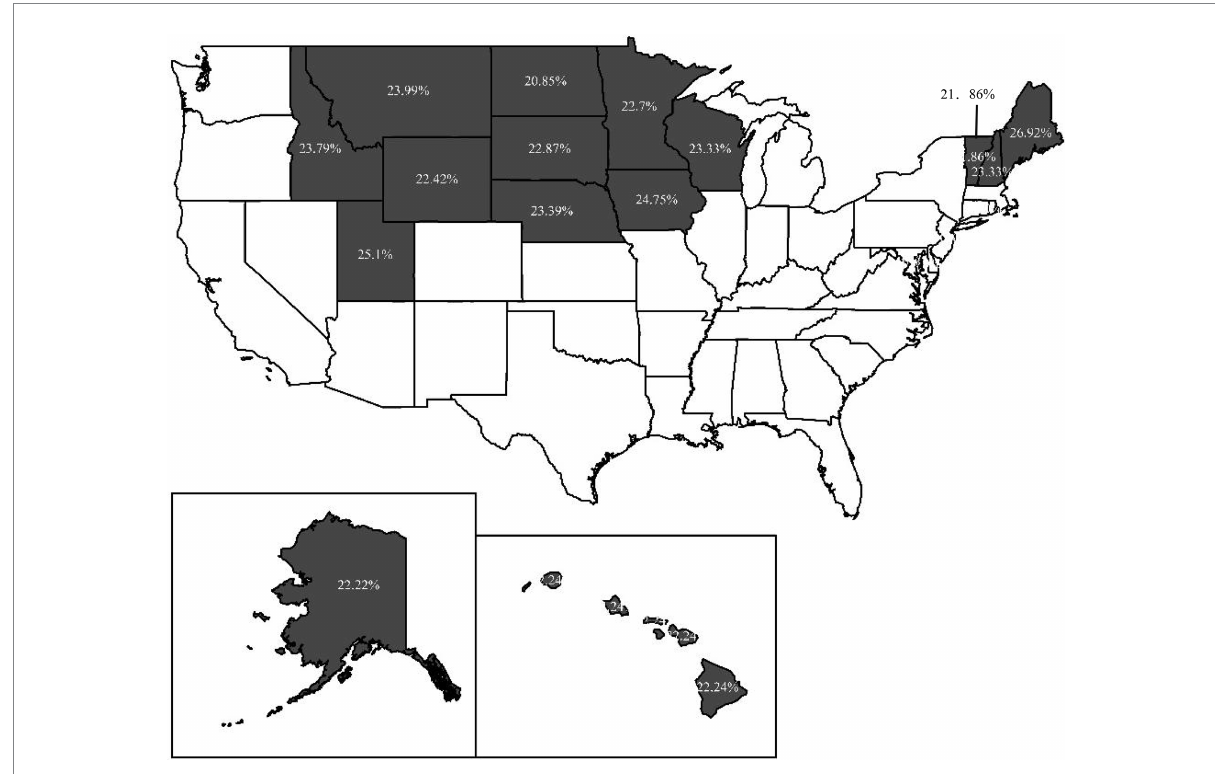
FIGURE 5 The distribution of the proportion of respondents with Y = 1 in 2015.